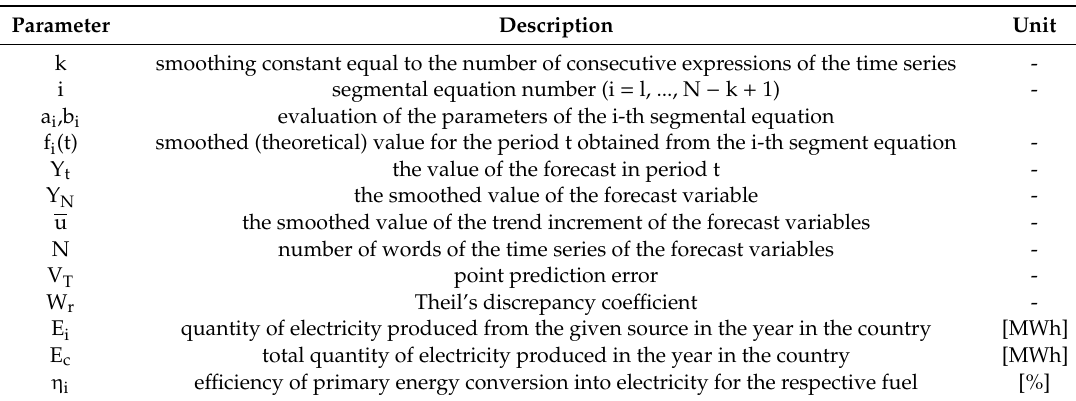
Table 1. Symbols and units used in